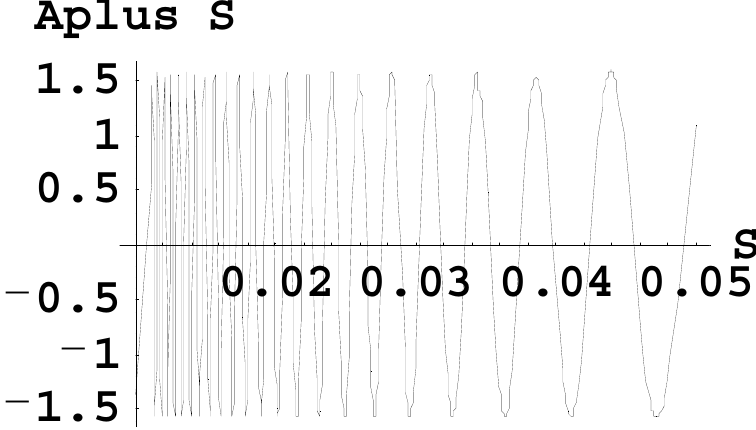
Figure 10. The integrand A + (s)/s, corresponding to the widths function a + , versus s = Z/ γ , where Z is the scaled impact parameter defined by Equation (8.2) and γ is the relativistic factor, as defined by Equation (8.3) [82].